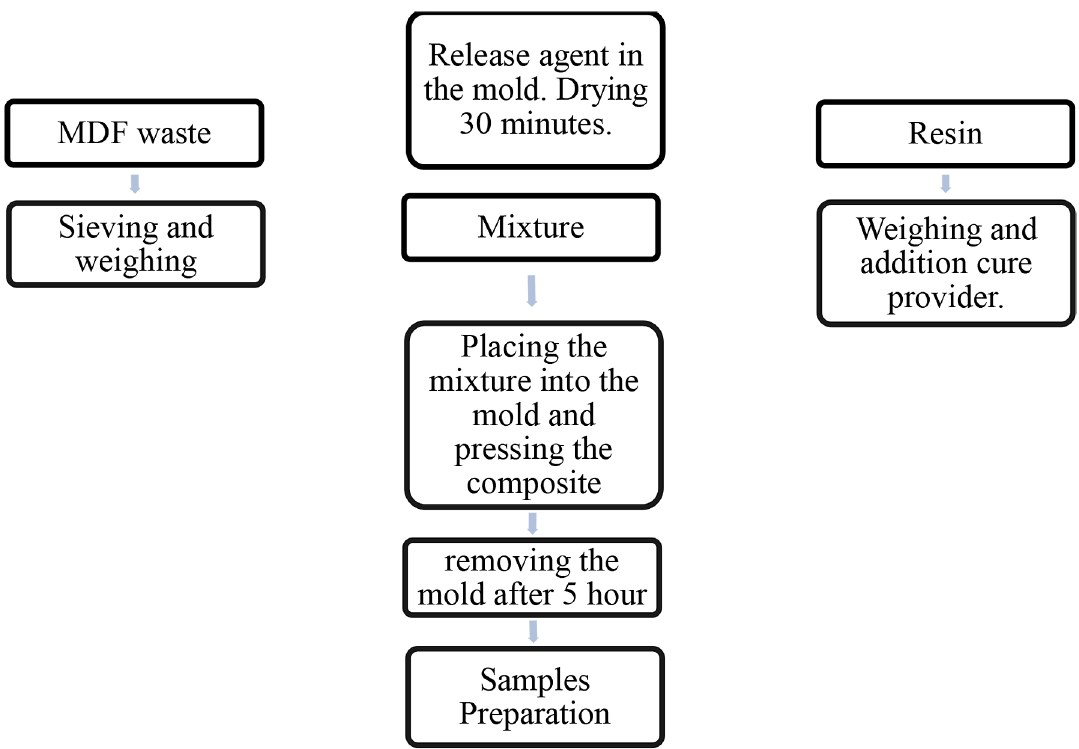
Figure 4. Flowchart of preparing composites and test samples.